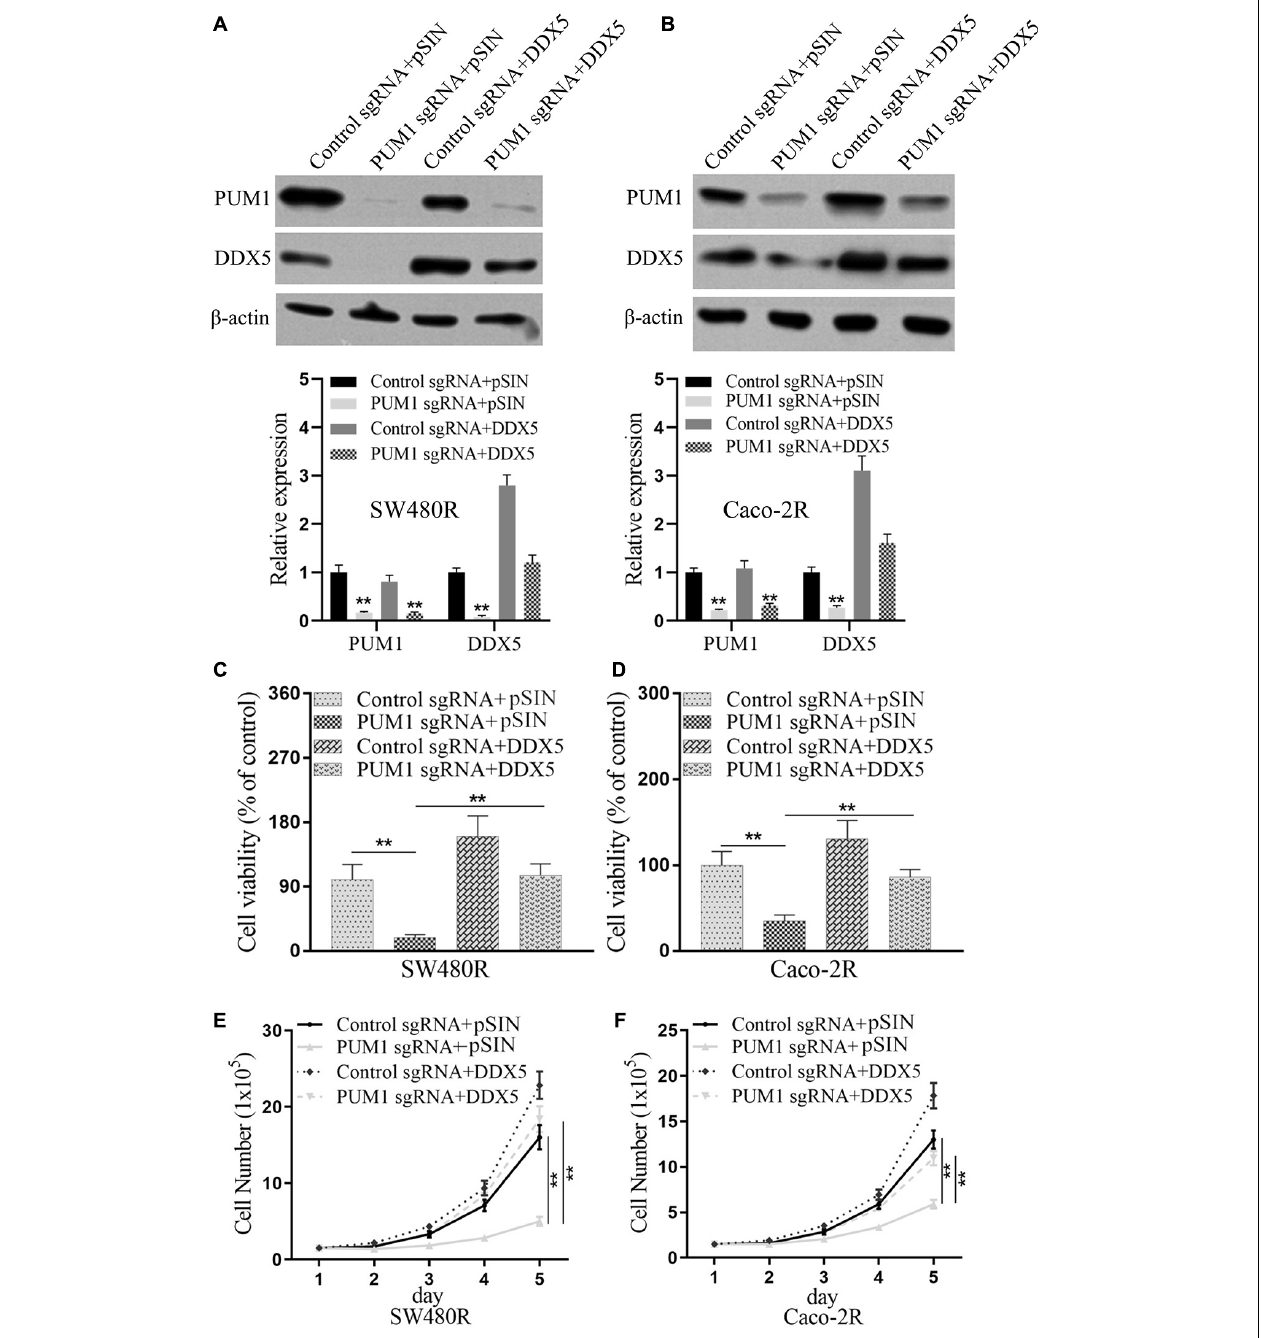
FIGURE 5 | DEAD-box helicase 5 (DDX5) is critical for pumilio RNA-binding family member 1 (PUM1)-mediated cetuximab resistance. Western blotting assay for the levels of PUM1 in (A) SW480R and (B) Caco-2 colon cancer cells. β -actin served as a loading control. (C) SW480R and (D) Caco-2R cells were incubated with or without cetuximab for 72 h, and cell viability was determined using the Cell Counting Kit-8 (CCK-8) assay. (E) SW480R and (F) Caco-2R cells were grown in six-well plates, and the cell number was determined. Data were presented as mean ± SD of three independent experiments. ** p <